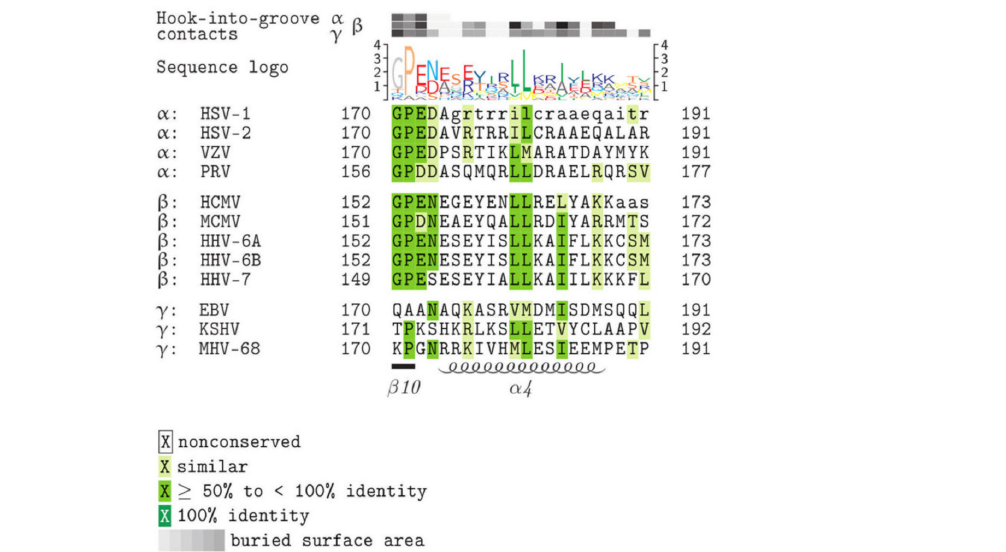
Figure 2. Core NEC protein sequence alignments, highlighting the functionally important hook and groove domains, conserved amino acids and amino acids representing contact interfaces. ( a ) Homologs of HCMV pUL53 (hook proteins), ( b ) homologs of HCMV pUL50 (groove proteins). Increasing levels of sequence conservation are indicated by darker shades of green in the alignment and by higher letters in the sequence logo above the alignment. Lower-case letters mark those residues that were not resolved in the crystal structures of the respective proteins. The buried surface area at hook-into-groove contact positions in α -, β -, and γ -herpesviruses is indicated by gray squares. Darker shades of gray indicate a larger buried surface. The elements of secondary structure are depicted schematically below the alignment. GenbankTM accession numbers: HSV-1, P10218 and P10215; HSV-2, P89457 and P89454; VZV, P09280 and P09283; PRV (SuHV-1), T2FKZ7 and G3G955; HCMV, P16791 and P16794; MCMV (MuHV-1), D3XDN8 and D3XDP1; HHV-6A, P52465 and P28865; HHV-6B, Q9QJ35 and Q9WT27; HHV-7, P52466 and P52361; EBV, P03185 and P0CK47; KSHV (HHV-8), F5HA27 and F5H982; MHV-68 (MuHV-4), O41968 and O41970.